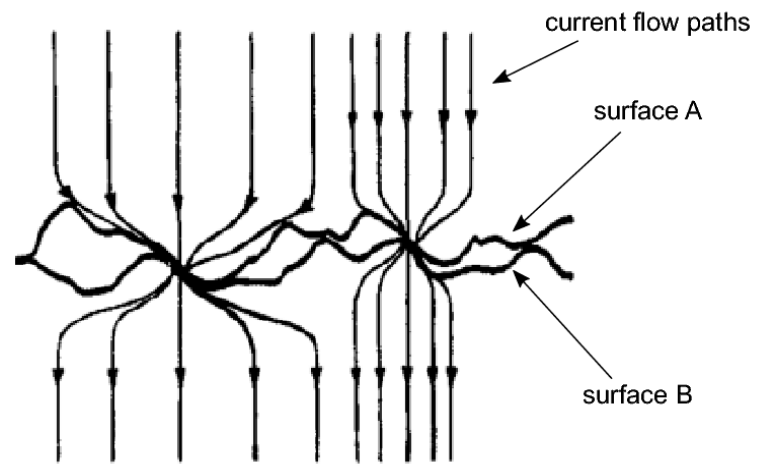
Figure 1. A sketch representing contact points and current flow between two surface. Adapted from [12].